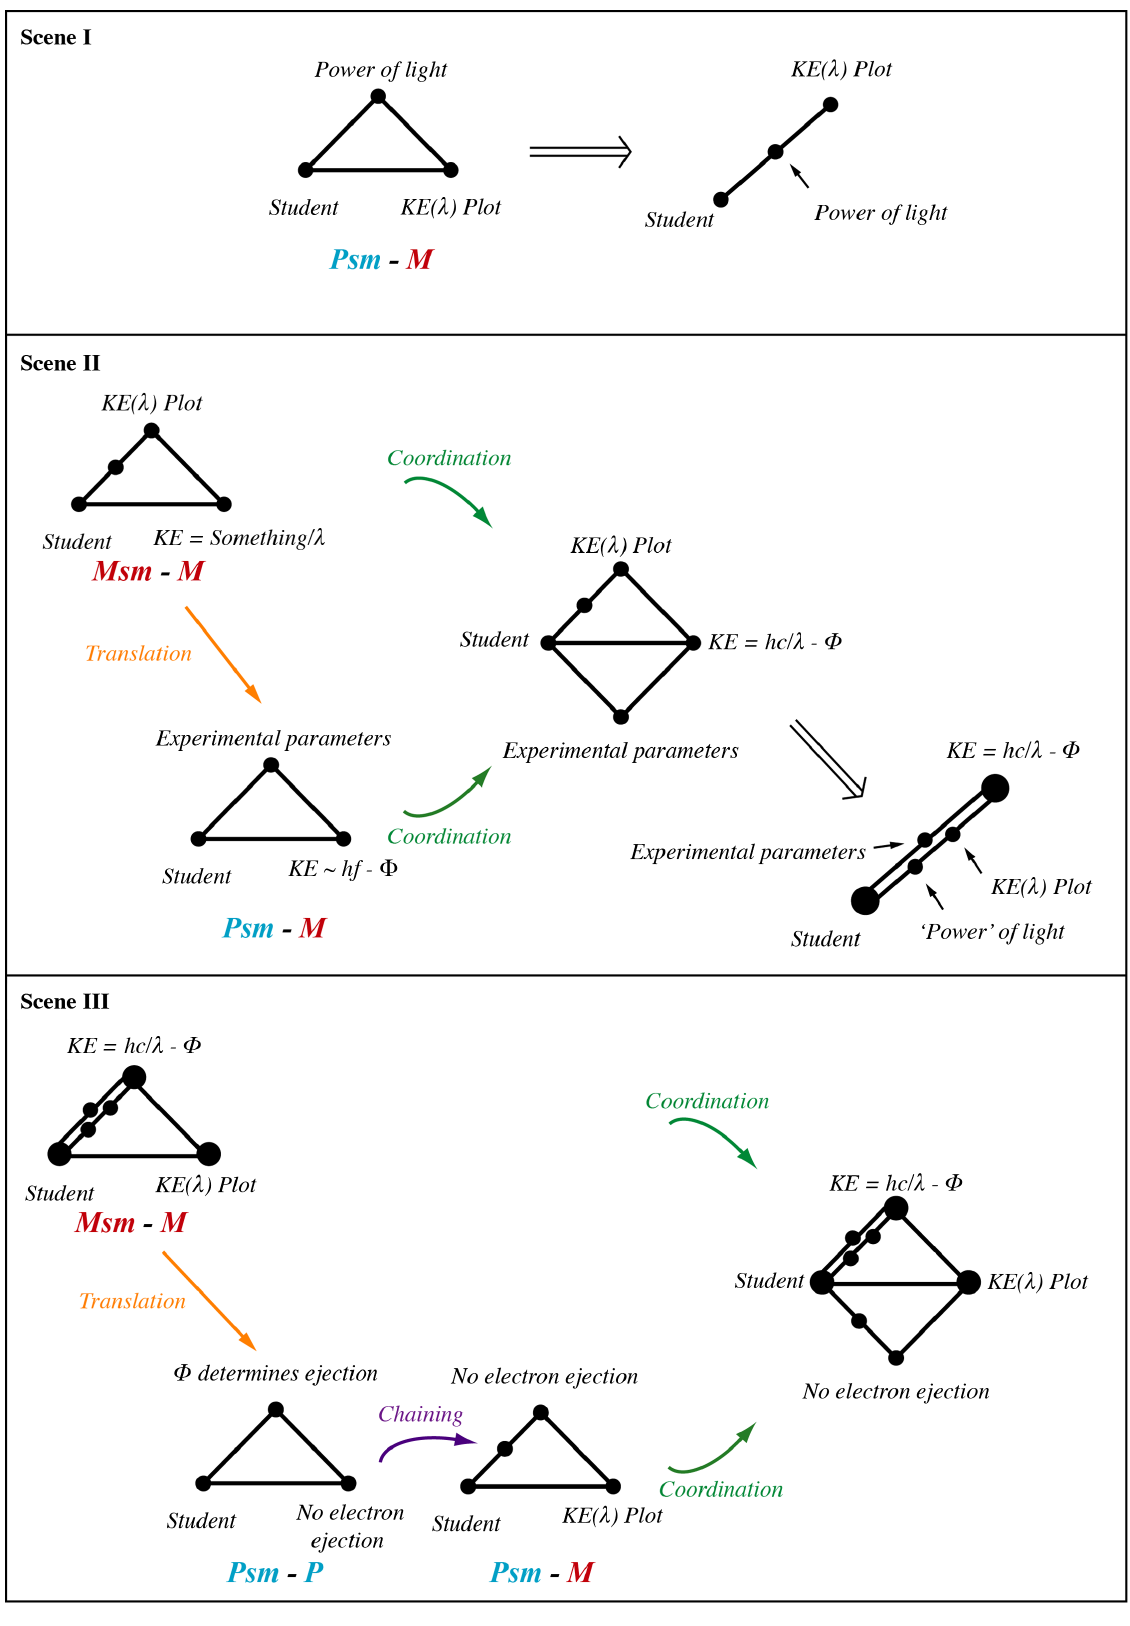
FIG. 9. A sense making diagram for the analysis of the three scenes of case study